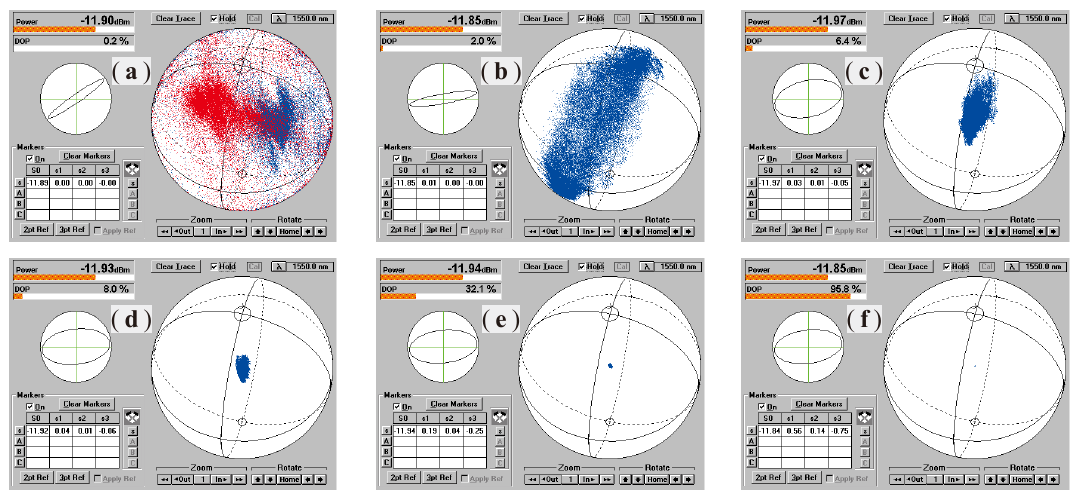
Figure 8. Distributions of the SOP of the output beam on the Poincar´e sphere measured at different DOP values, changing from 0.2% ( a ) to 95.8% ( f